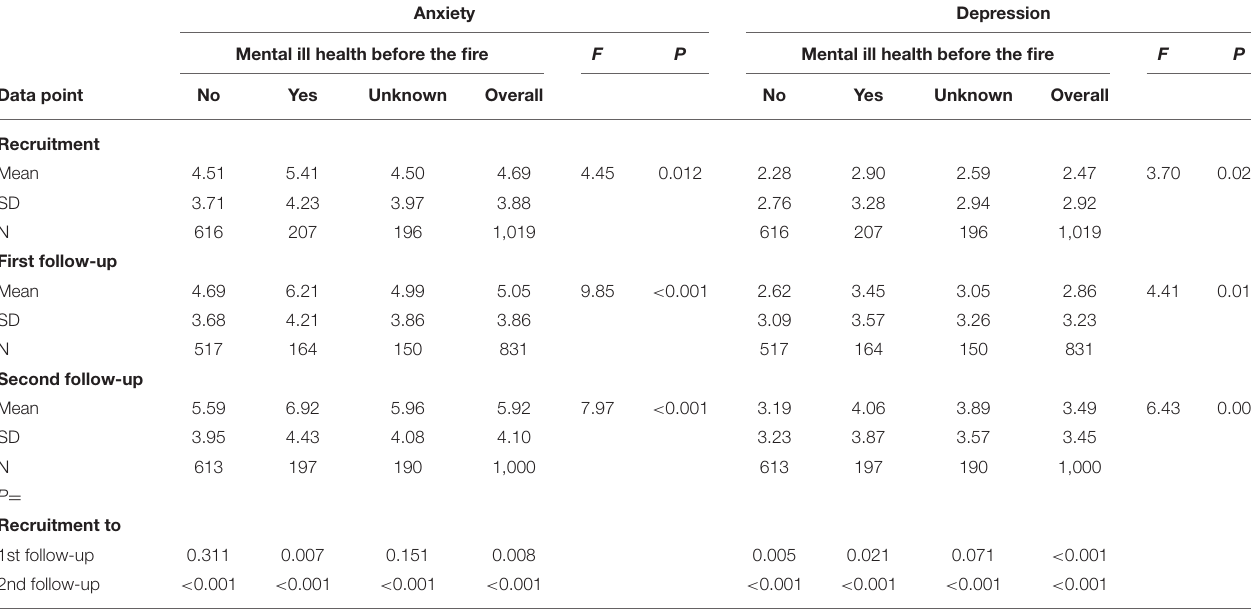
TABLE 8 | Mean anxiety and depression scores by mental ill health before the fire, at recruitment and at each follow-up. Anxiety